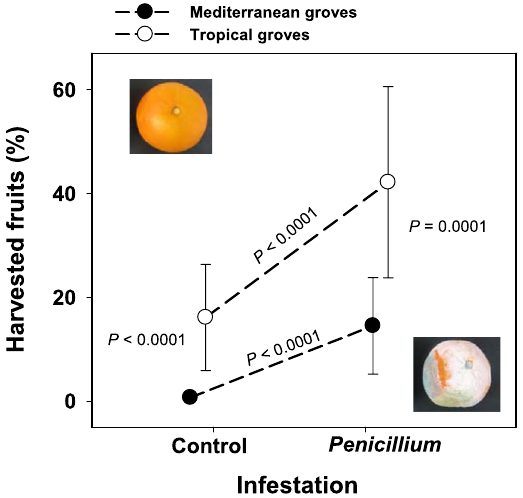
Figure 1. Harvesting by vertebrate frugivores (mammals and birds) of intact and Penicillium -infested oranges. Graphical representation of statistically significant interaction between Penicillium infestation (intact vs . Penicillium -infested) and region (tropical vs . Mediterranean) found for overall fruit harvesting by vertebrate frugivores of sweet orange ( Citrus sinensis ) fruit in our experimental Mediterranean and tropical groves. The P - values of the tests for the four simple main effects involved in the interaction are